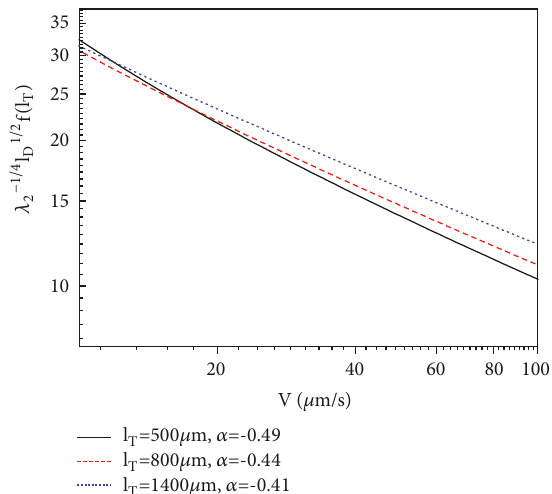
Figure 2: The scaling law between the critical primary spacing and the pulling velocity with different thermal lengths in the cell- dendrite transition, described by formula (5), where 𝜆 2 ≈ 350 V −0.6 , 𝑎 =0.1, and 𝑛 =2.